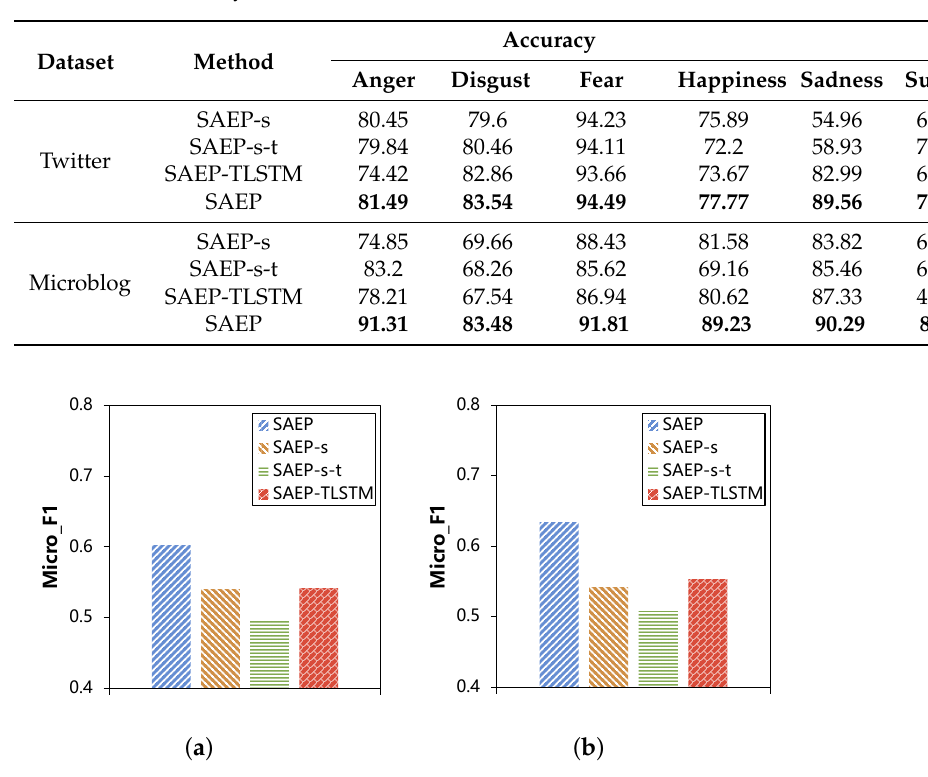
Figure 10. Ablation analysis results “micro F1” on two datasets. ( a ) Twitter; ( b )